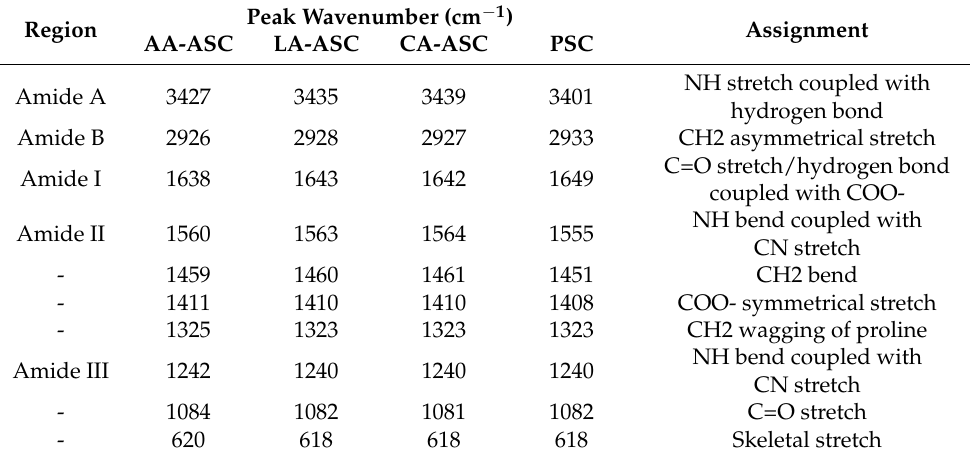
Table 2. FTIR spectra peak locations and their assignments for ASC and PSC from the skin of purple-spotted bigeye